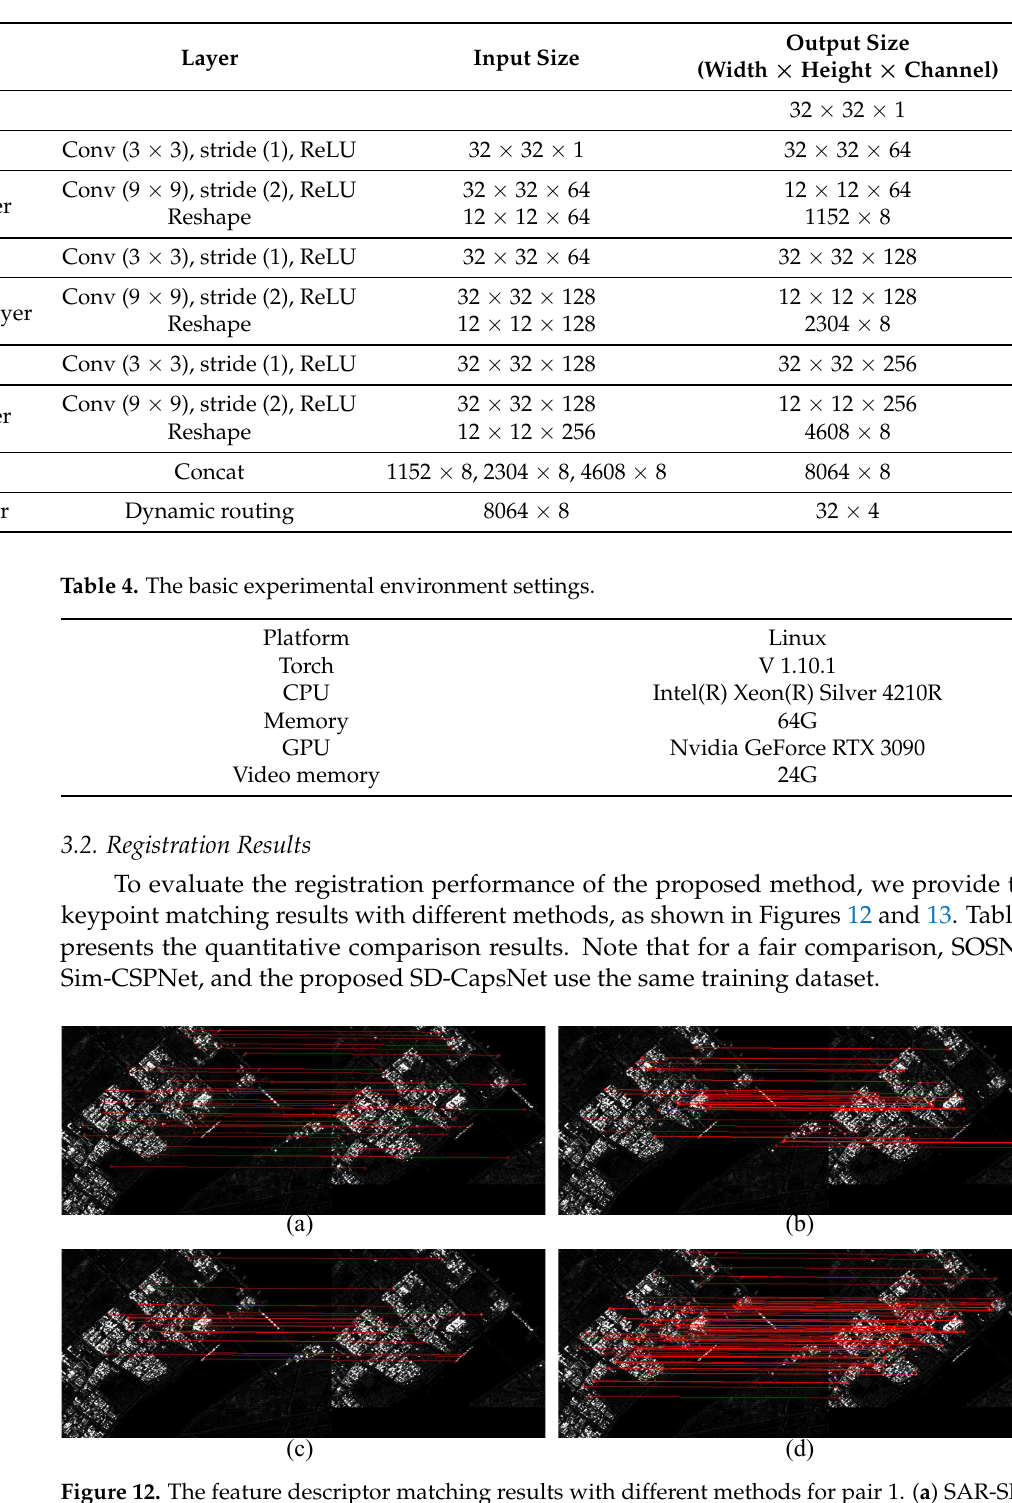
Table 3. Model specifications and parameters of the SD-CapsNet.